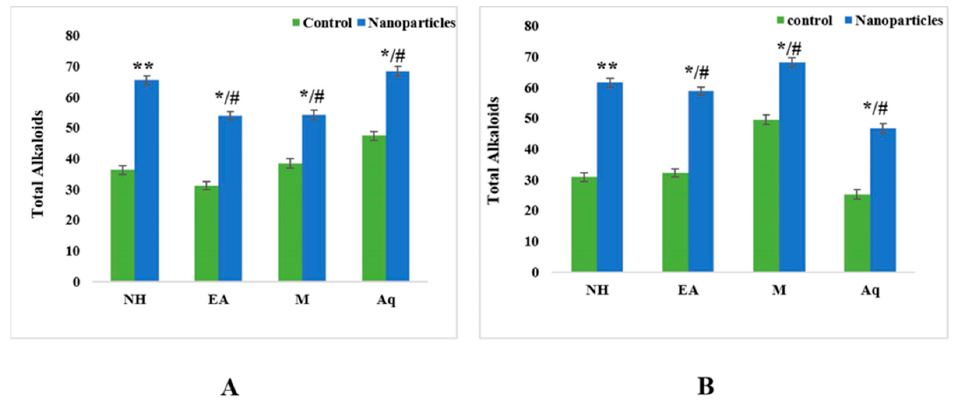
Figure 9. Total alkaloid contents of control and nanoparticles from ( A ) leaf and ( B ) fruit extracts of C. colocynthis . Mean ± SD is expressed as */# p < 0.05, ** p < 0.01.